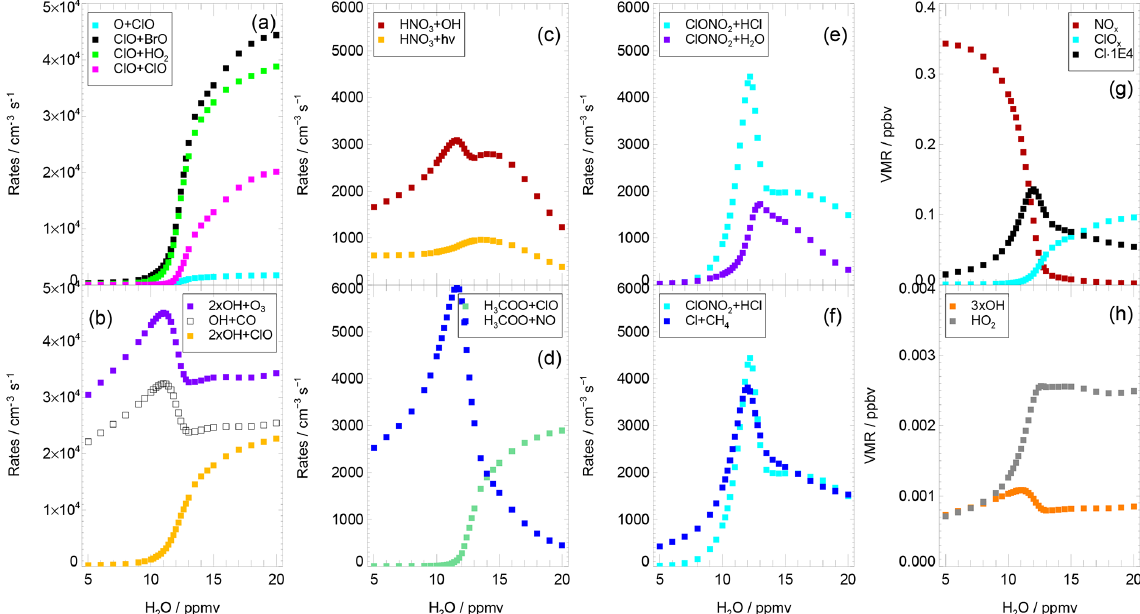
Figure 5. Average reaction rates and volume mixing ratios from the standard simulations on 3 August dependent on water vapour con- tent. Panel (a) shows the reaction rates of Reaction (R16) (ClO + ClO), Reaction (R17) (ClO + BrO), Reaction (R13) (ClO + HO 2 ) and ClO + O ( 3 P ) −→ Cl + O 2 resulting in ozone reduction; panel (b) possible reaction pathways for the OH radical (Reaction R4, OH + CO, Reaction R18, OH + ClO, and Reaction R15, OH + O 3 ); panel (c) reactions yielding depletion of HNO 3 (Reaction R19, HNO 3 + OH, Re- action R20, HNO 3 + hν ); panel (d) reactions of the H 3 COO radical (Reaction R22, H 3 COO + ClO, and Reaction R21, H 3 COO + NO); panel (e) important heterogeneous reactions (Reaction R1, ClONO 2 + HCl, Reaction R2, ClONO 2 + H 2 O); and panel (f) the balance be- tween Reaction (R1) (ClONO 2 + HCl) and Reaction (R12) (CH 4 + Cl). Panel (g) shows the mixing ratios of NO x , ClO x and 1000 · Cl and panel (h) the mixing ratios of OH and HO 2 .